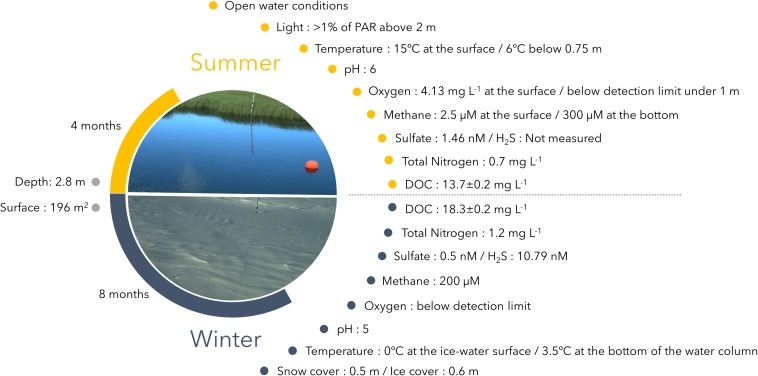
Study site characteristics with photographs taken at the two sampling times. Geochemical data (methane, nitrogen and DOC) are from Matveev et al. (2016, 2019). Sulfate data were provided by courtesy of J. Canario (University of Lisbon).